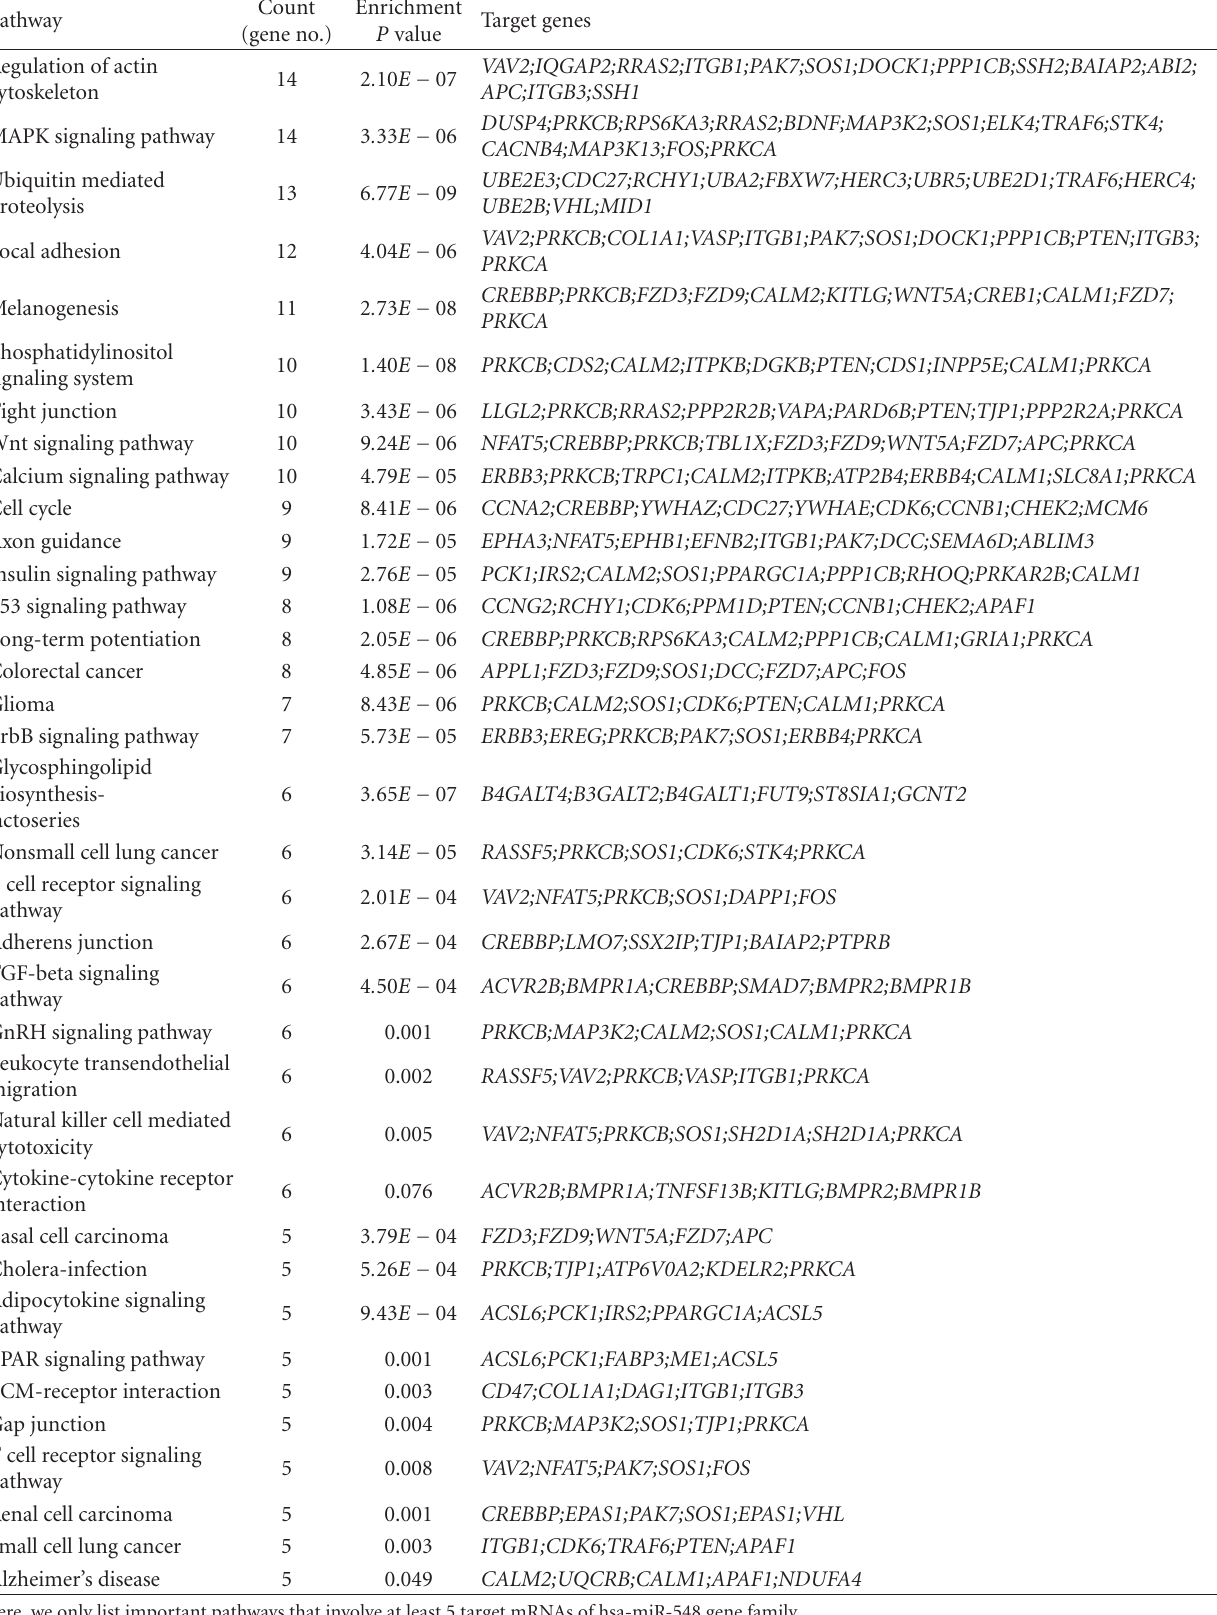
Table 1: Target genes of hsa-miR-548 gene family enrichment pathway